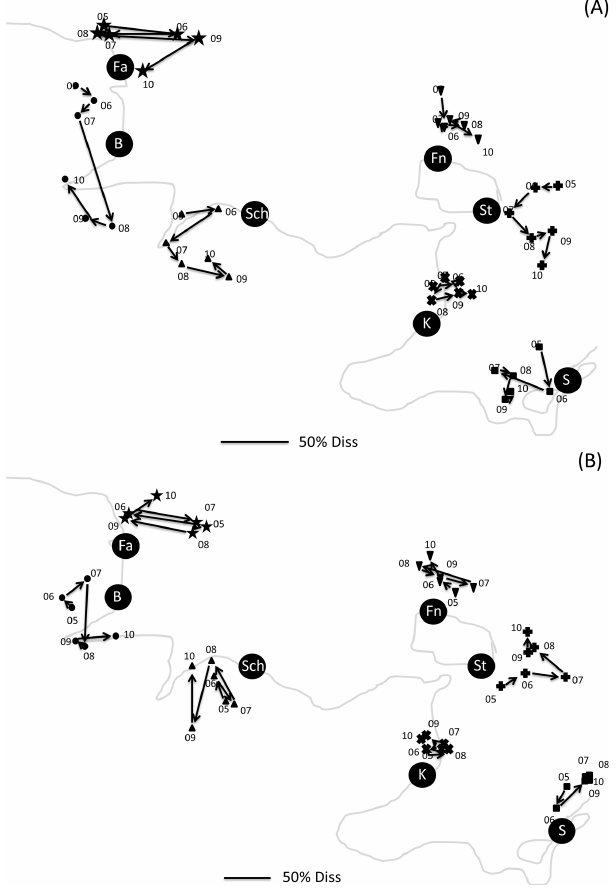
Fig. 9. MDS trajectories between consecutive years for taxonomic (A) and functional (B) composition of the panel communities. The station codes (Fa–S) are placed on the approximate position of the site relative to the coast line in light grey. Within, but not between, compositional categories (species (A) , functional groups (B) ) are all plots drawn to scale, i.e. same lengths and directions of trajec- tories correspond to an equivalent amount of dissimilarity between consecutive years. A scale bar indicating the 50% dissimilarity dis- tance is given in each